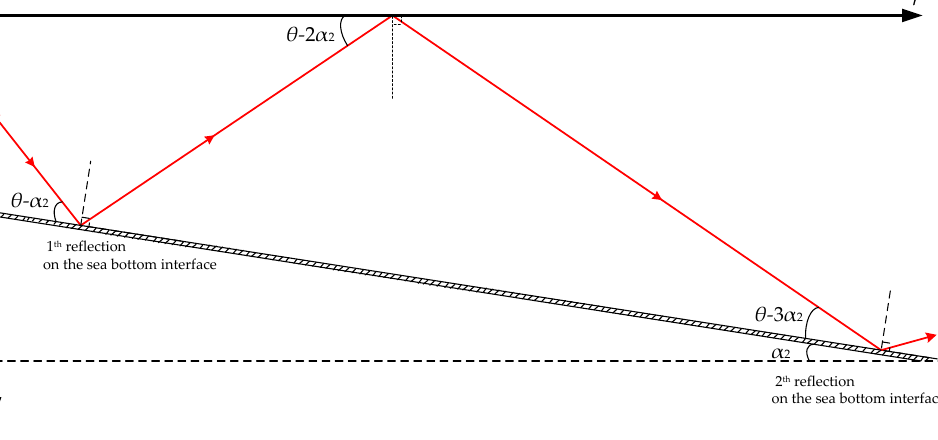
Figure 8. Distribution of the ray tracing when acoustic signals propagate in a shallow water environment with wedge-shaped downhill sea bottom, and the downhill slope angle of the wedge-shaped bottom is α 2 .